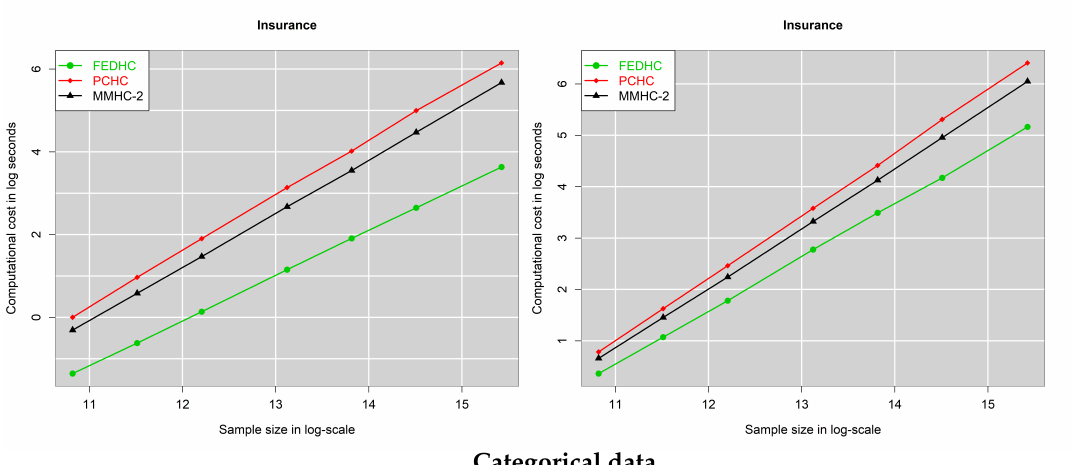
Figure 11. Scalability of the algorithms with respect to the sample size for some selected cases. The results for the other cases convey the same message and are thus not presented. The left column refers to the skeleton identification phase, whereas the right column refers to both